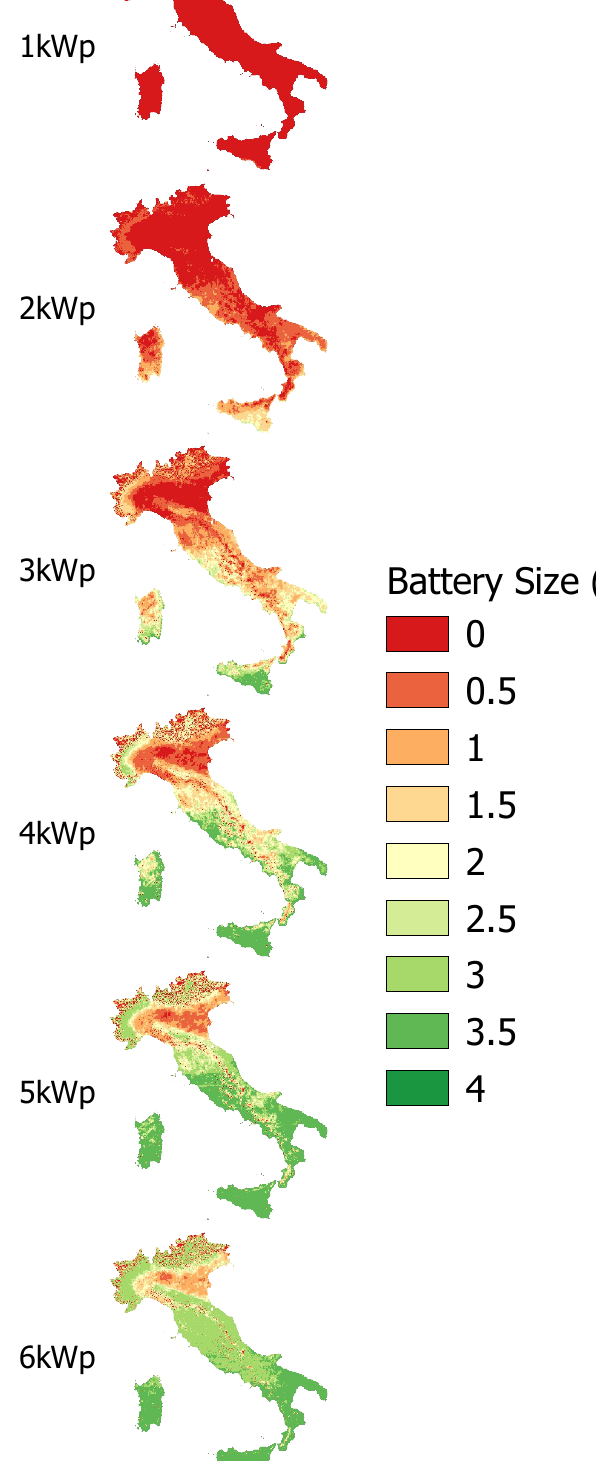
Figure A1. Battery size for E L = 2700